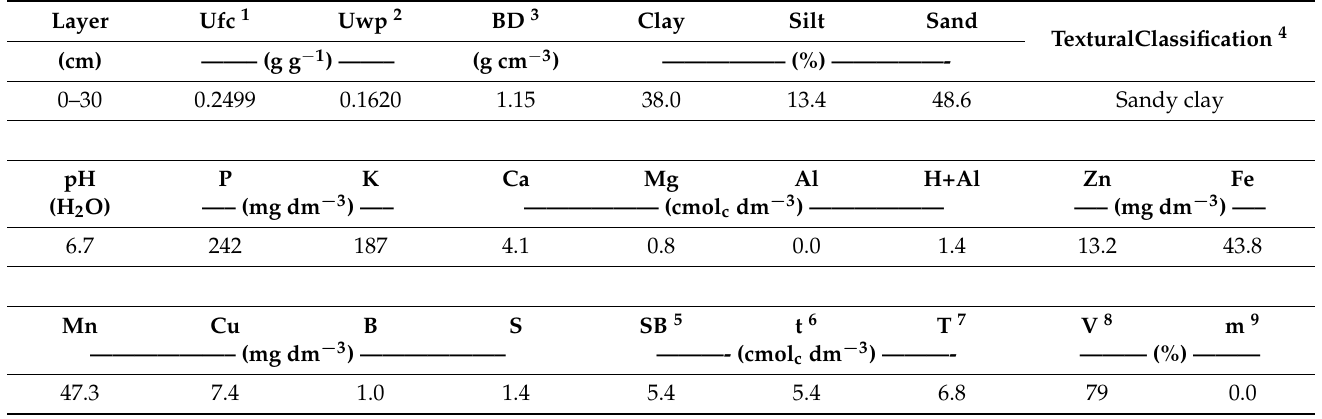
Table 1. Results of physical-hydraulic and chemical analyses of the soil before the experiment. Silt